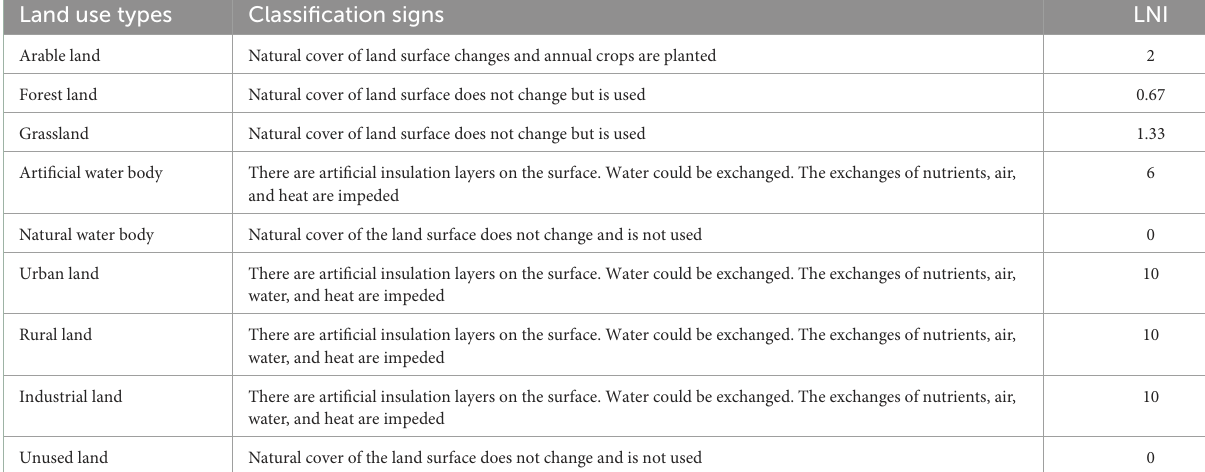
TABLE 3 Land use naturalness index of the different land use types in the Huaihe River Basin. Land use